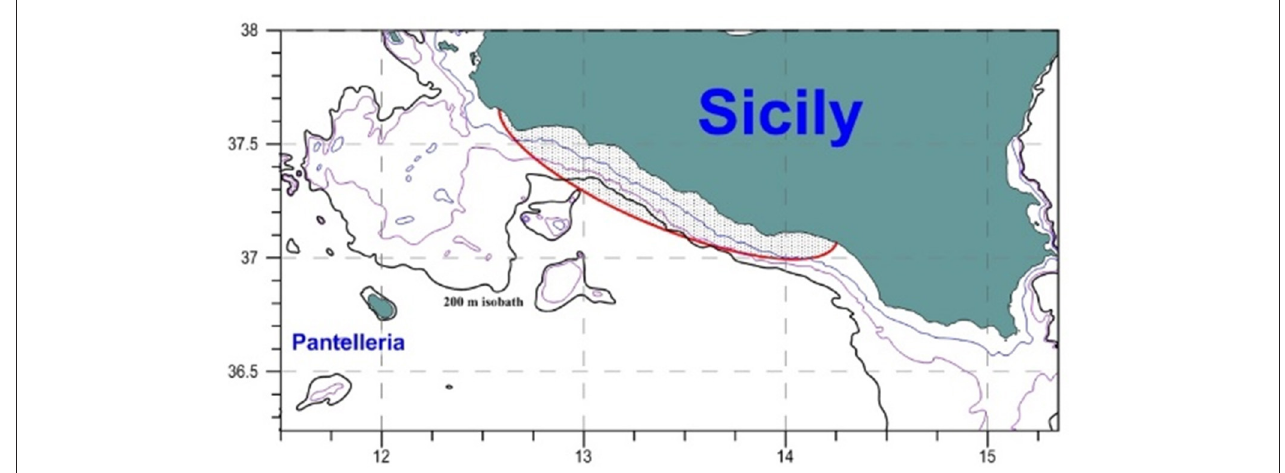
FIGURE 1 | Map of the study area with the main fishing ground located in the shadowed sector, according to Basilone et al. (2004). Isobaths of 50m, 100m, and 200m (black line).